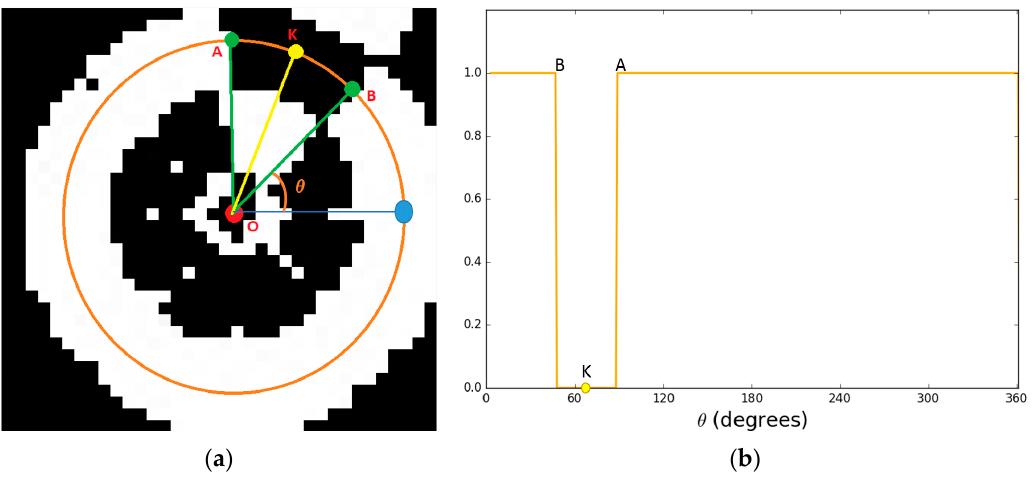
Figure 10. Detected center and direction of marker in ( a ) result image using our proposed method. ( b ) Profile visualization from the circle of Figure 10a.